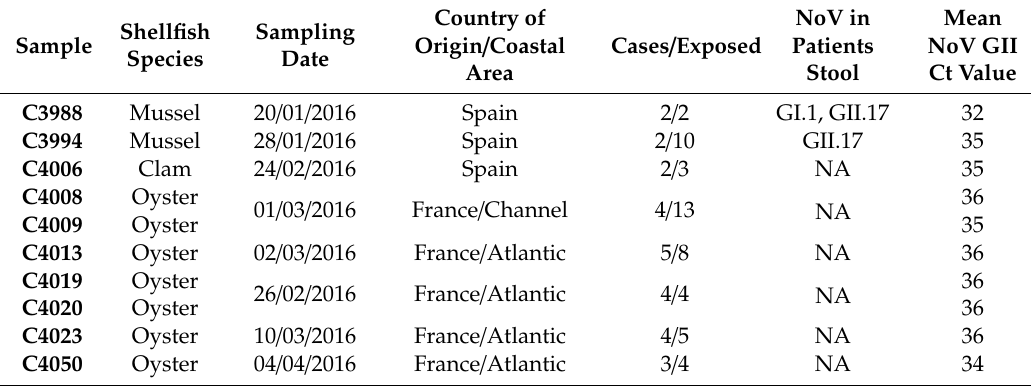
Table 1. List and characteristics of outbreak-related shellfish